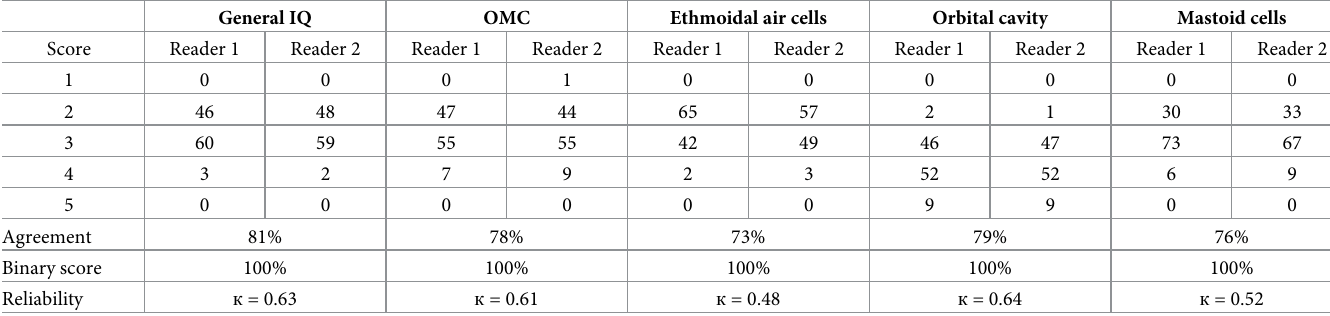
Table 2. Subjective image